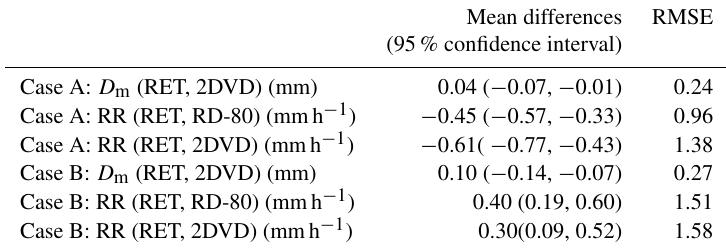
Figure 4. Time series of (a) retrieved (RET) (red dots) and 2DVD surface disdrometer estimated (grey line) D m , (b) RET (red line), 2DVD (grey line) and RD-80 (black line) surface disdrometer rain rate estimates, and (c) retrieved rain liquid water path (RLWP; red dots) for Case A (20 May 2011). The red shading areas are the estimated retrieval uncertainties. Table 2. Statistics (mean differences, 95% confidence interval of mean differences, and RMSEs) of D m and RR between this study (RET) and disdrometers (2DVD, RD-80) for Case A and Case